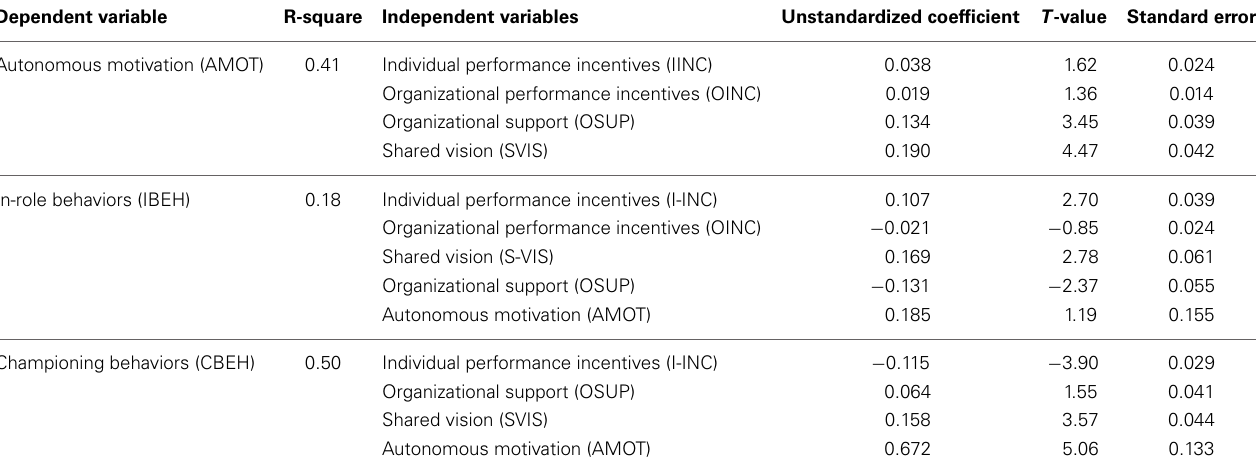
Table 6 | Statistical relationships between structural model constructs.